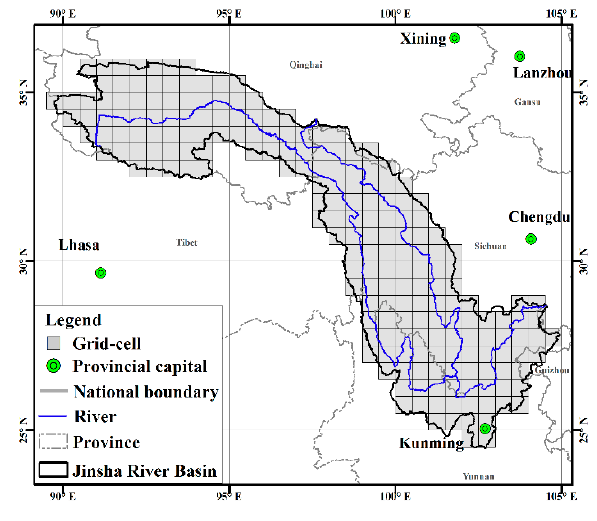
Figure 2. Grid cells in the JRB.